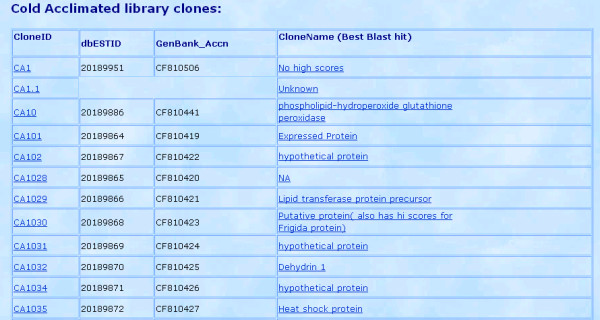
The sequence database allows users to browse a specific library in table format. This snap shot represents part of the table that was returned by the database. Users can get the sequence by clicking on the clone ID and/or can query PubMed for relevant articles by clicking on the gene name.